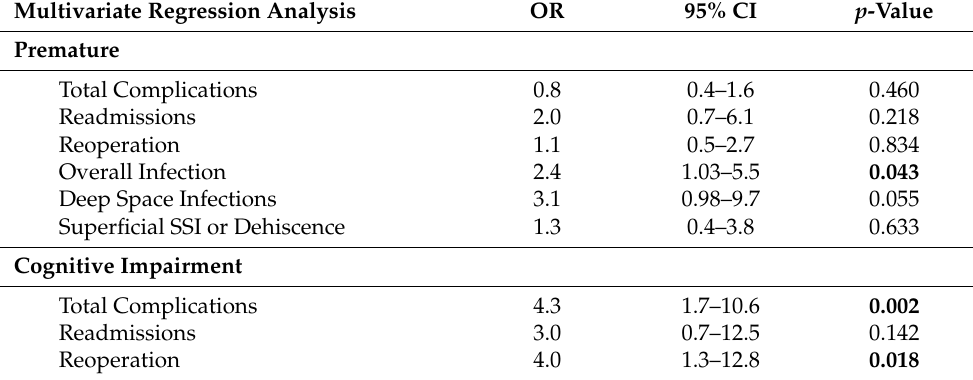
Table 5. Prematurity and baseline cognitive impairment, neuromuscular disease, cerebral palsy, previous cardiac surgery, structural pulmonary/airway abnormality, asthma, chronic lung disease, seizure disorder, and esophageal/GI disease) as predictive factors for 30-day postoperative complica- tions, readmission, and reoperations in propensity-score matched premature and term patients who underwent PSF for AIS. Bold values are statistically significant ( p < 0.05).